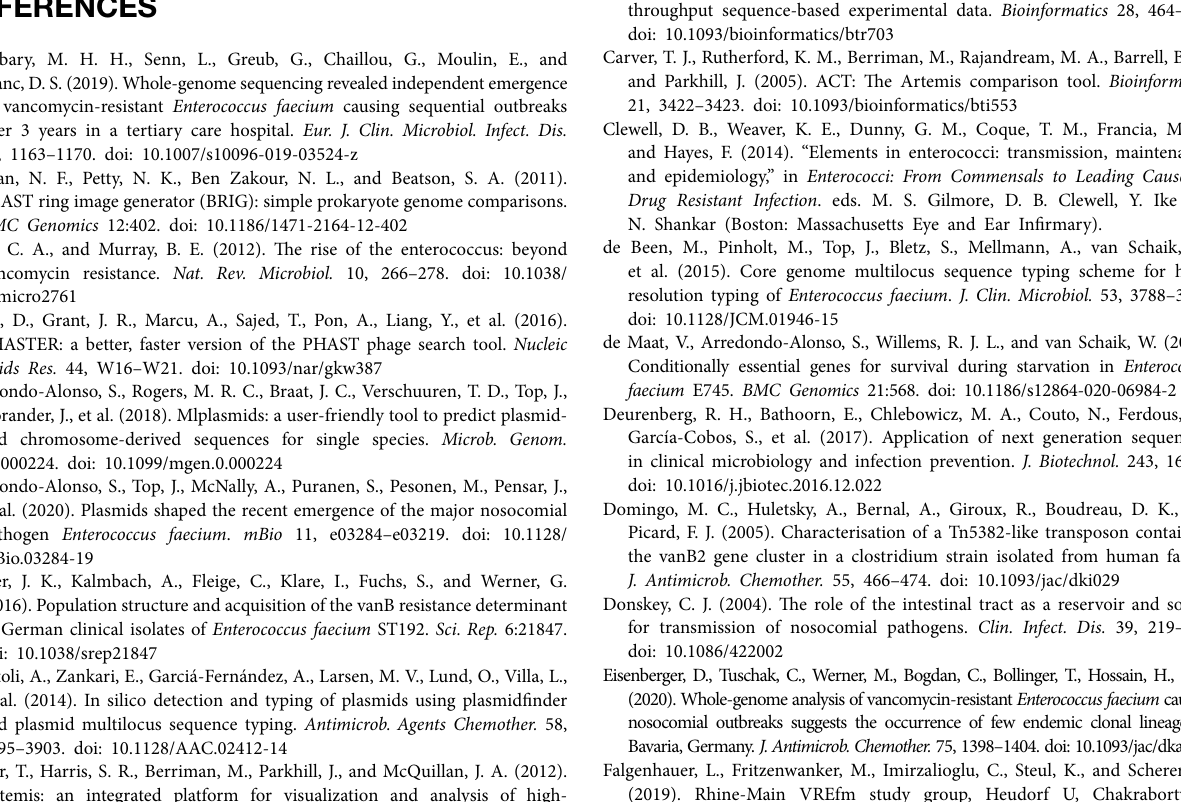
Supplementary Figure 1 | Overview of the pangenome and accessory genes analysis. The neighbour-joining tree is based on cgMLST (1,423 target genes). The presence and absence of the predicted resistances genes, bacteriocin, and virulence factors are indicated with coloured and white cells, respectively. Similarly, the presence and absence of a gene in the pangenome matrix is depicted with blue and white lines, respectively. On the pangenome matrix, the in silico predicted bacteriocins and resistance genes which could distinguish the clusters have been highlighted with orange and red lines, respectively. Supplementary Figure 2 | Nucleotide and amino acid alignment of vanB gene in the representative isolates. Clonal isolates (100% identity) from 2014 and 2017 outbreaks are not depicted in the alignments and were represented by isolates A12 and B11, respectively. Supplementary Table 1 | Assembly statistics. Supplementary Table 2 | Pangenome analysis results. List of all the genes identified in the isolates and those uniquely reported in the 2014 and 2017 outbreak.